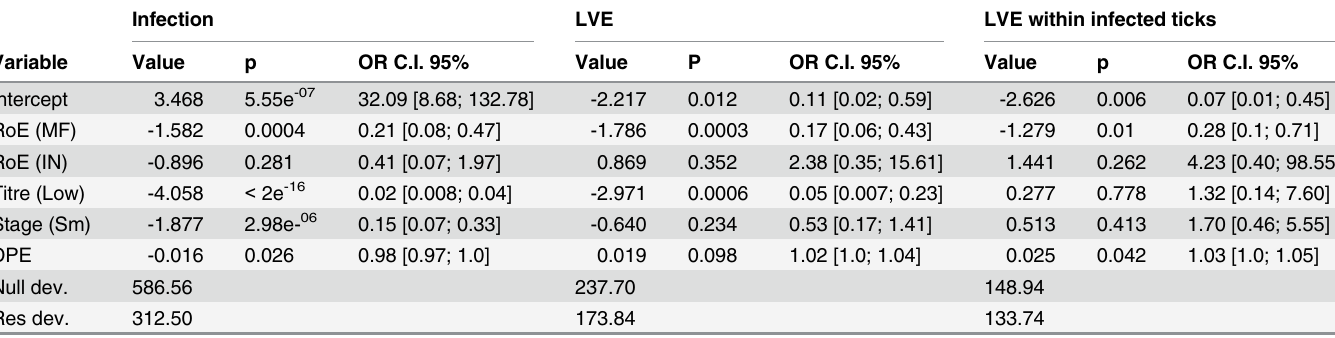
Table 8. Logistic regression model C — Effect of route of exposure (Pig feeding versus inoculation and membrane feeding) and titre of exposure (high and low titres), controlling for tick stage and days post exposure, in infection (n = 499), likelihood of virus excretion (LVE) (n = 499) and likeli- hood of virus excretion within the infected ticks (LVE within the infected ticks) (n = 137). Infection LVE LVE within infected